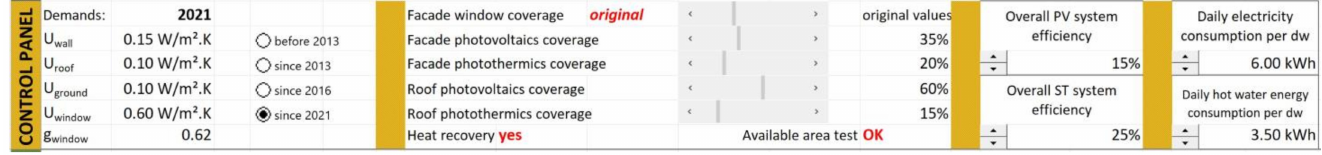
Figure 12. Overview of the Excel calculation sheet control panel with the pre-set